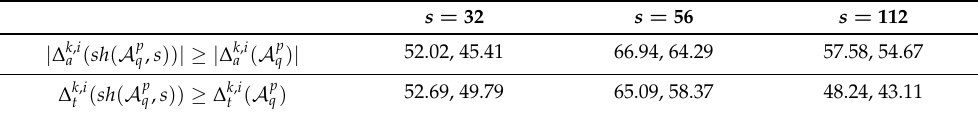
Table 4. For the c a -label value (second row) and the c t -label value (third row), the percentage of cases where the adversarial noise has a stronger impact when shuffled than unshuffled. In each cell, the first percentage corresponds to atk = EA , and the second corresponds to atk = BIM . s =